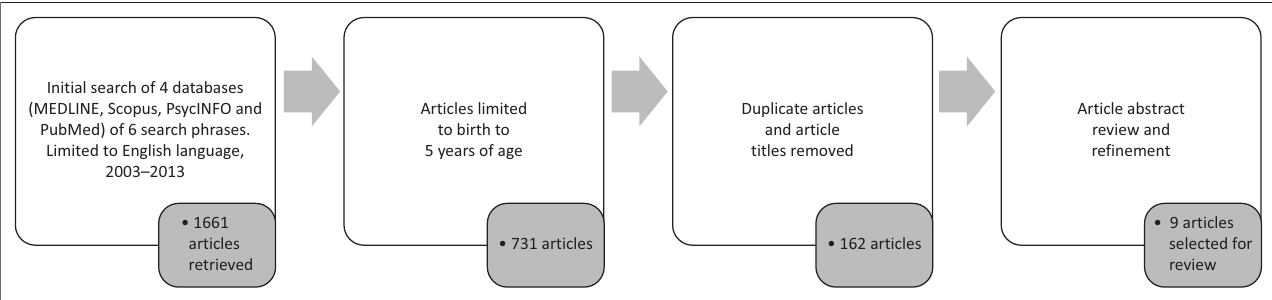
FIGURE 1: Review phases used to identify articles for